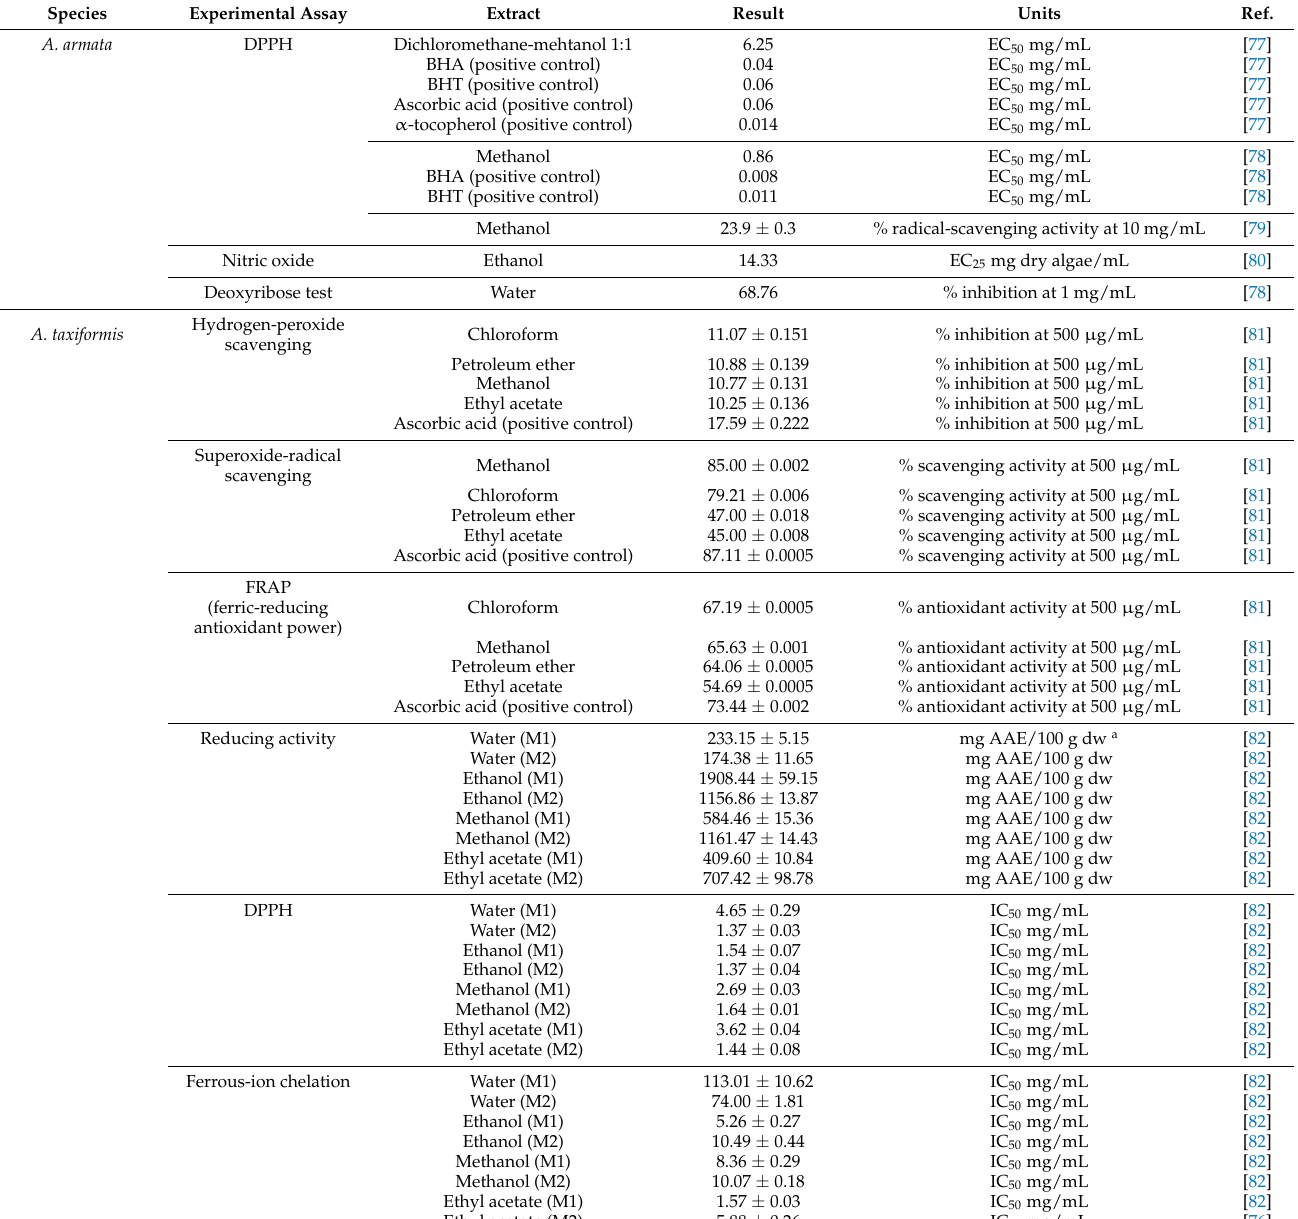
Table 1. Antioxidant activity of Asparagopsis